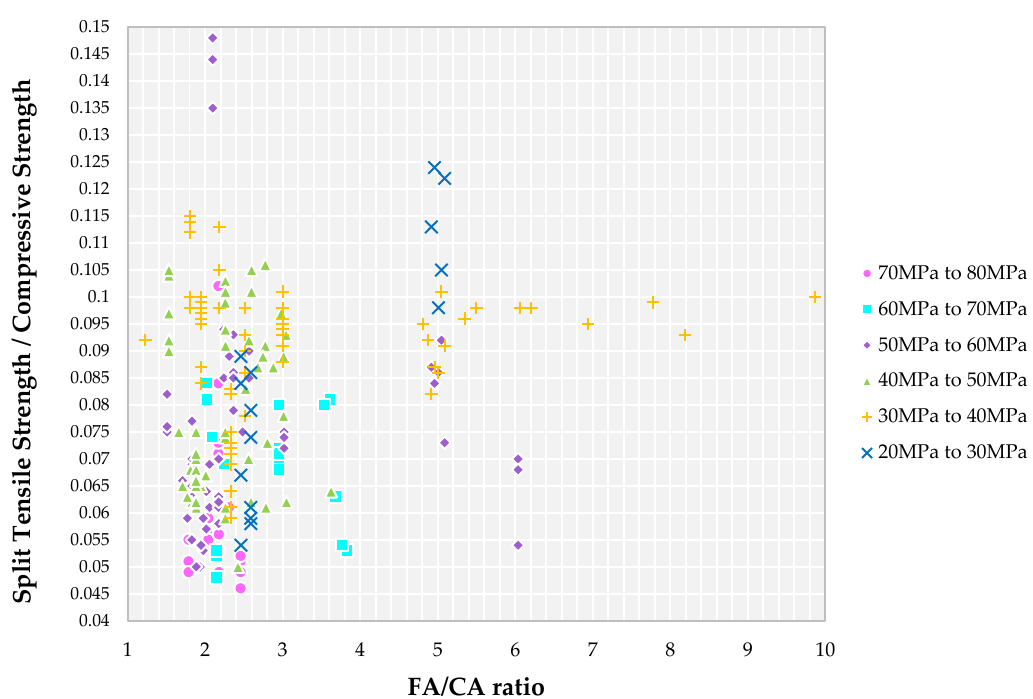
Figure 6. Impact of FA/CA ratio on split tensile strength to compressive strength ratio for different grades of SCC concrete with recycled aggregate according to literature.